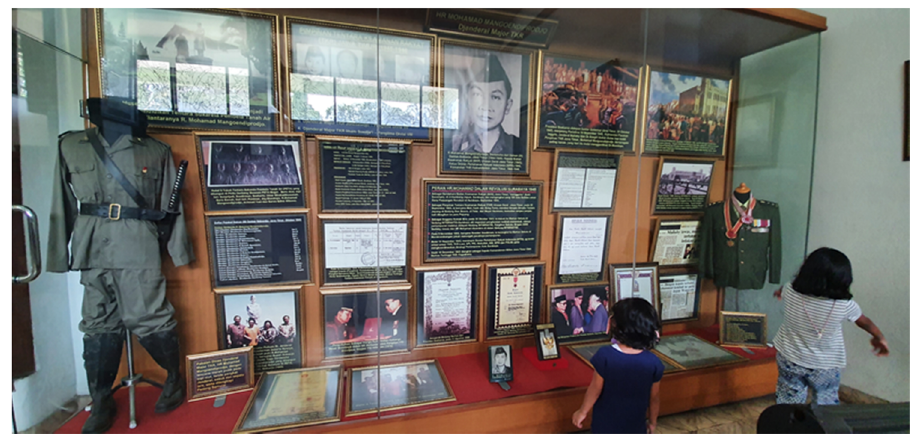
Figure 7: Wall case in Museum